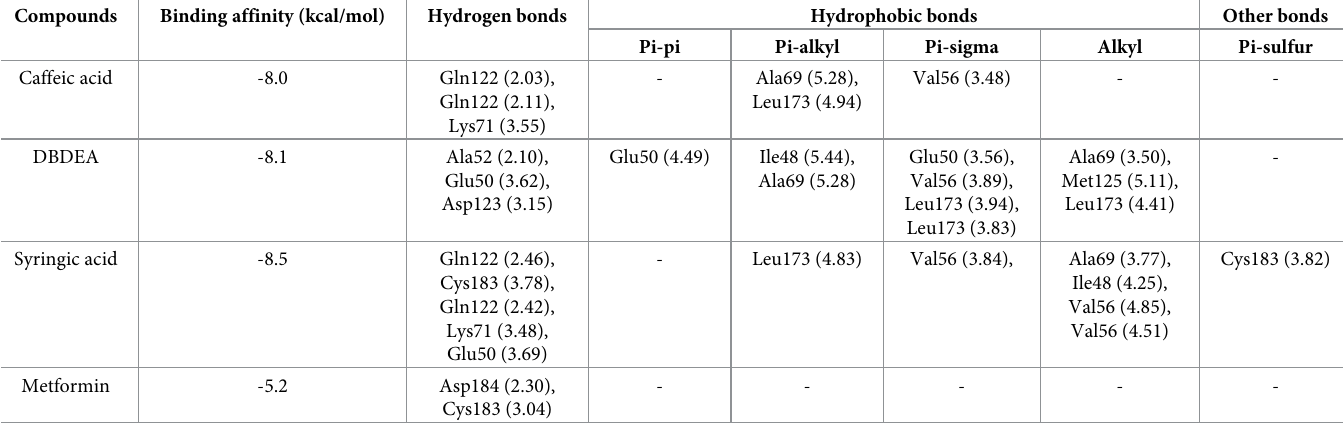
Table 3. Binding interactions of compound 6b and acarbose with α -glucosidase along with their bond length ( Å ). Compounds Binding affinity (kcal/mol) Hydrogen